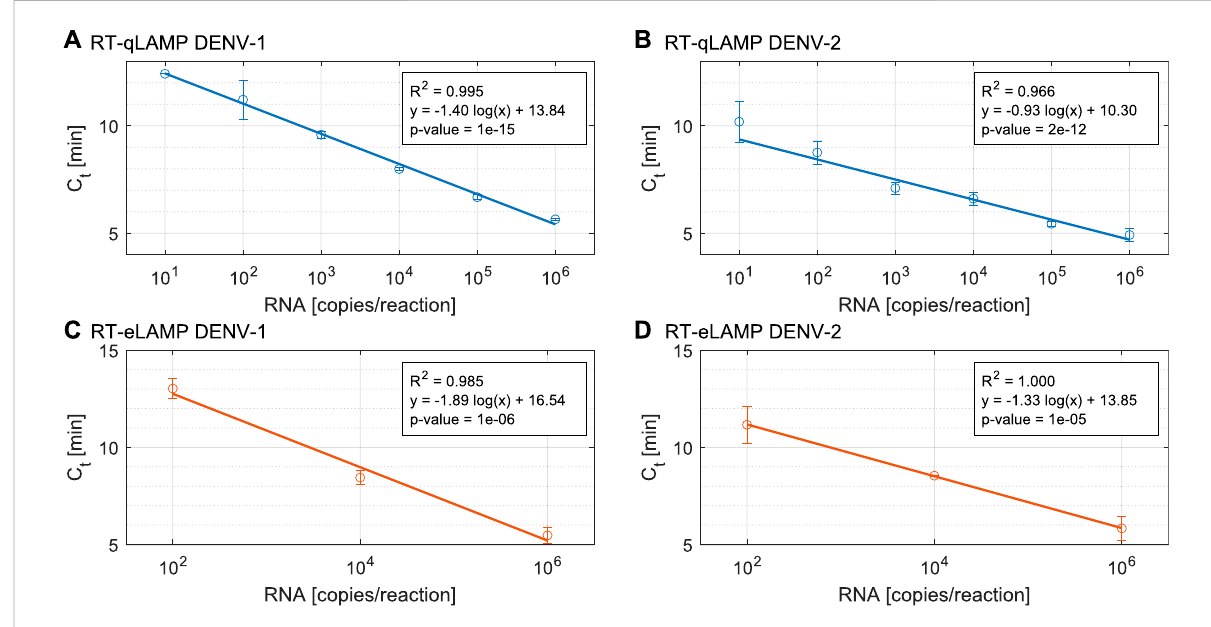
FIGURE 3 Performance of the DENV RT-qLAMP assay (n = 4) for (A). DENV-1 and (B). DENV-2 and Performance of the DENV RT-eLAMP assay (n = 3) for (C). DENV-1 and (D). DENV-2.